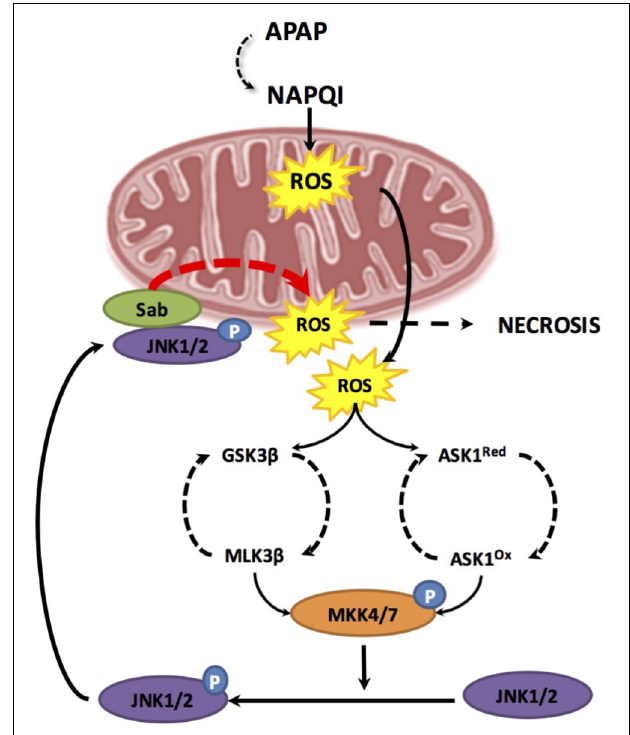
involves mitochondrial glutathione depletion due to its covalent binding to the reactive metabolite NAPQI resulting from APAP metabolism through CYP2E1. GSH depletion results in enhanced mitochondrial reactive oxygen species (ROS) production. Increase ROS leads to two phases of mitogen-activated protein kinase (MAPK) activation, including MLK3 most likely through GSK-3b and ASK-1. Both pathways result in the activation of MKK4/7 which in turn activates JNK. Once JNK is activated by phosphorylation, it translocates to the mitochondria and binds to Sab. This leads to a sustained production of mitochondrial ROS triggering a positive feedback loop which results in self-amplification of MAPK activation pathways, MPT, mitochondrial failure and